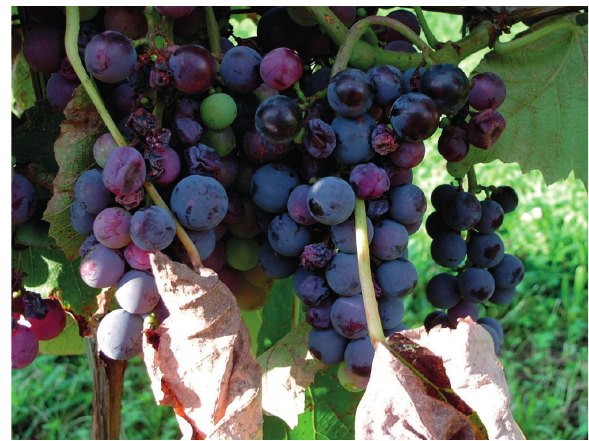
Figure 9. Plasmopara viticola hyphae in infected grape leaf tissue after aniline blue staining (Nikon Eclipse80l, Em filter 420–490 nm).